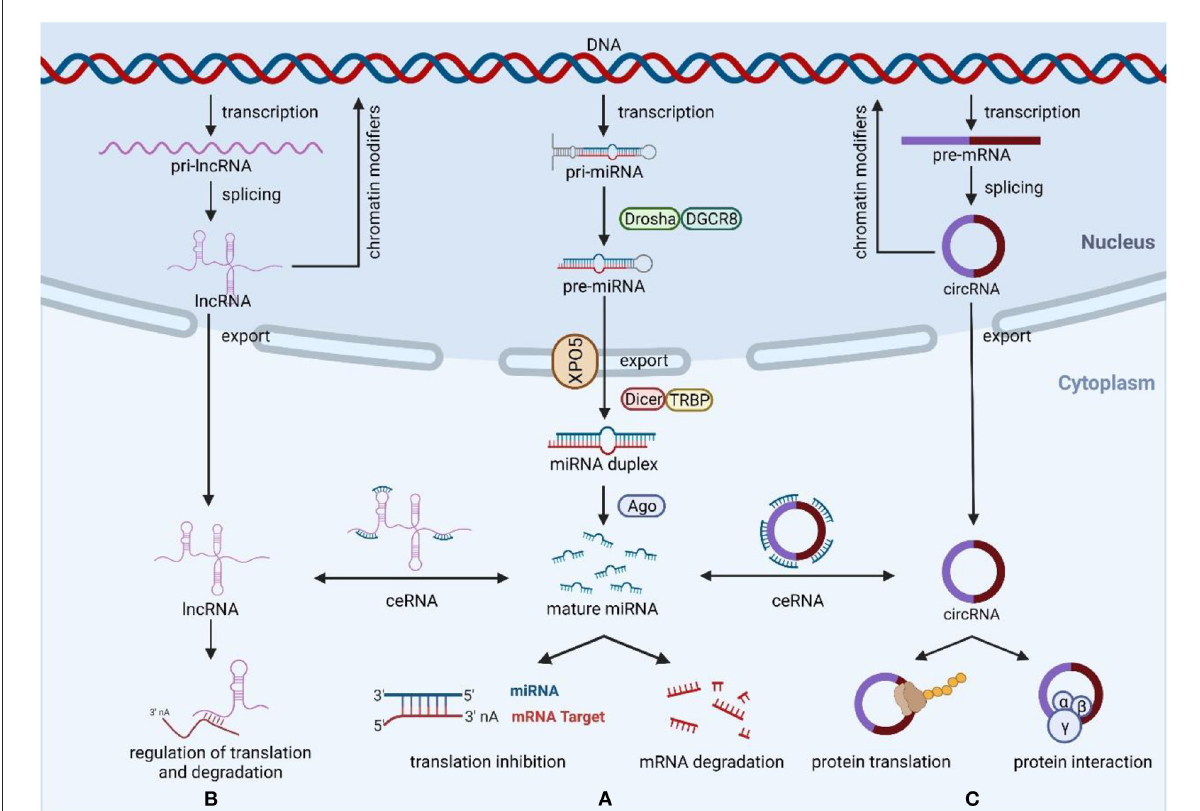
FIGURE1 Biogenesis and function of miRNAs, lncRNAs, and circRNAs. (A) The ncRNAs genes are transcribed to generate pri-miRNAs, Drosha, and DGCR8 process pri-RNAs to pre-miRNA, then export the pre-miRNAs from nucleus to cytoplasm via exportin-5, and generate miRNA duplexes by Dicer and TRBP processing. Mature miRNAs regulate the expression of target mRNAs through degradation or translational repression. (B) Most transcribed lncRNAs are polyadenylated at 3 ′ , 5 ′ capping and splicing. LncRNAs exert their functions mainly through three mechanisms of action, including miRNA spongeization, regulation of translation and degradation, and modifiers of parental gene expression. (C) CircRNAs are formed by back-splicing of pre-mRNA, and their main functions include miRNA sponges, protein interactions, protein translation, and regulation of parental genes. Created with